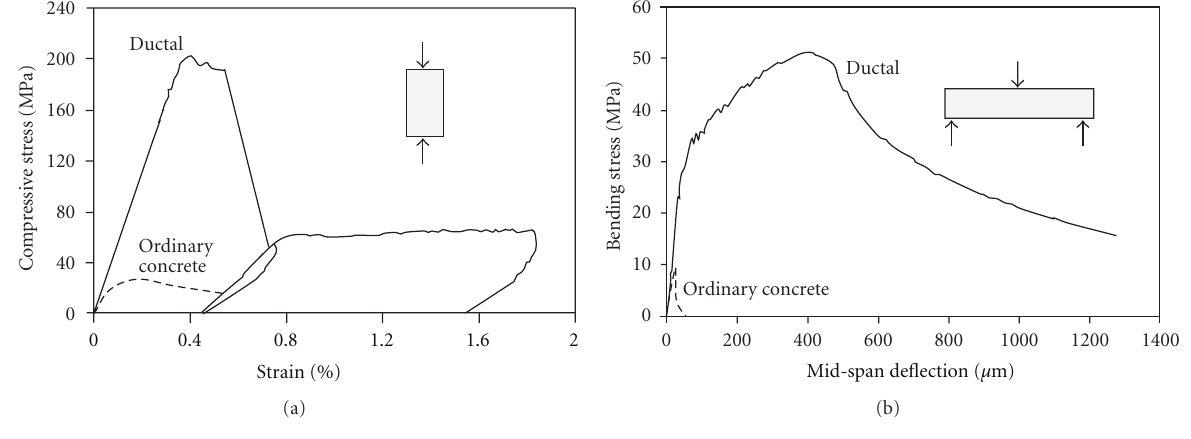
Figure 2: Behavior of Ductal in compression (a) and in bending (b)